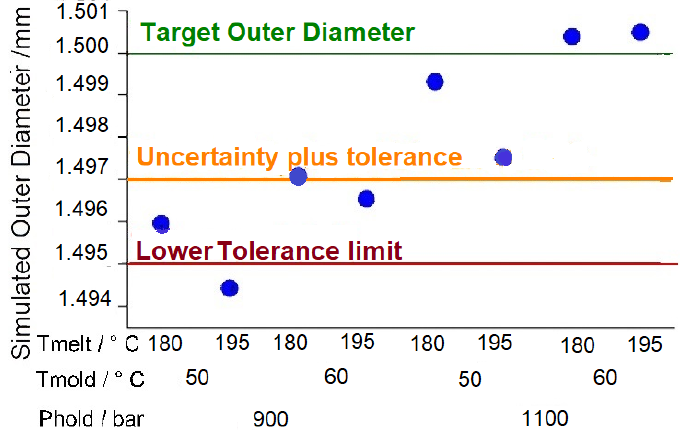
Figure 8. Simulated optimal process conditions for the outer diameter of the micro-ring.